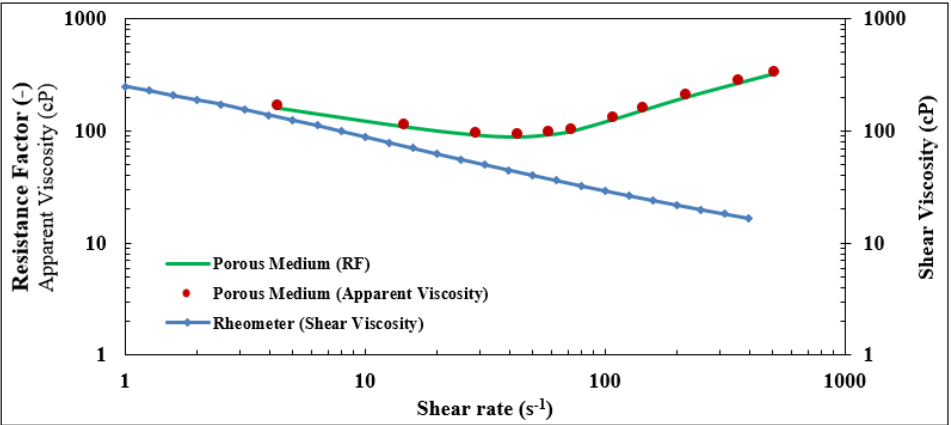
Figure 5. Viscosity profiles of prefiltered Polymer B (3000 ppm) as measured in the porous medium and in bulk.